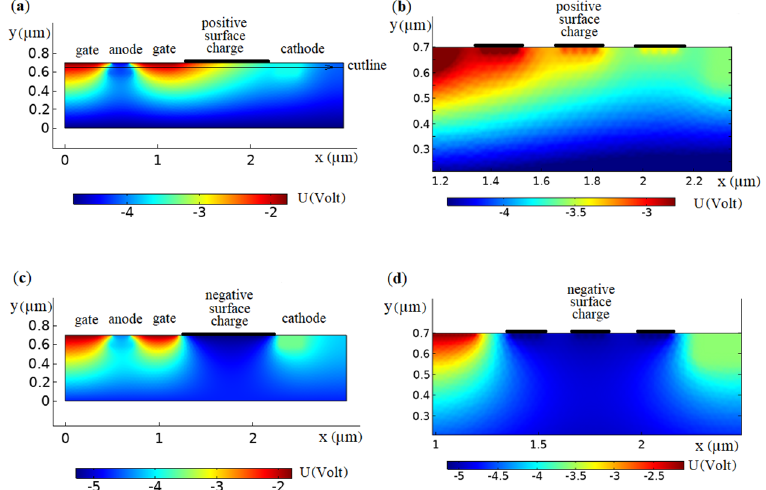
Figure 2. Potential distribution inside the p -type GaAs target (concentration of dopant is p = 10 12 cm − 3 ) with positive surface charge located between cathode and anode of the model device with uniform surface density ρ , C · m − 2 ( a , c ) and three surface islands ( b , d ): ( a ) +10 − 3 ; ( b ) +10 − 2 ; ( c ) − 10 − 3 ; ( d ) − 10 − 2 . Thin oxide or dielectric layer was located between the surface charge and the bulk. Cathode voltage U ct = 0.5 V, anode voltage U an = 1 V, gate voltage U g = 3 V. Color gradation presents the potential distribution range, as shown in the color lines.